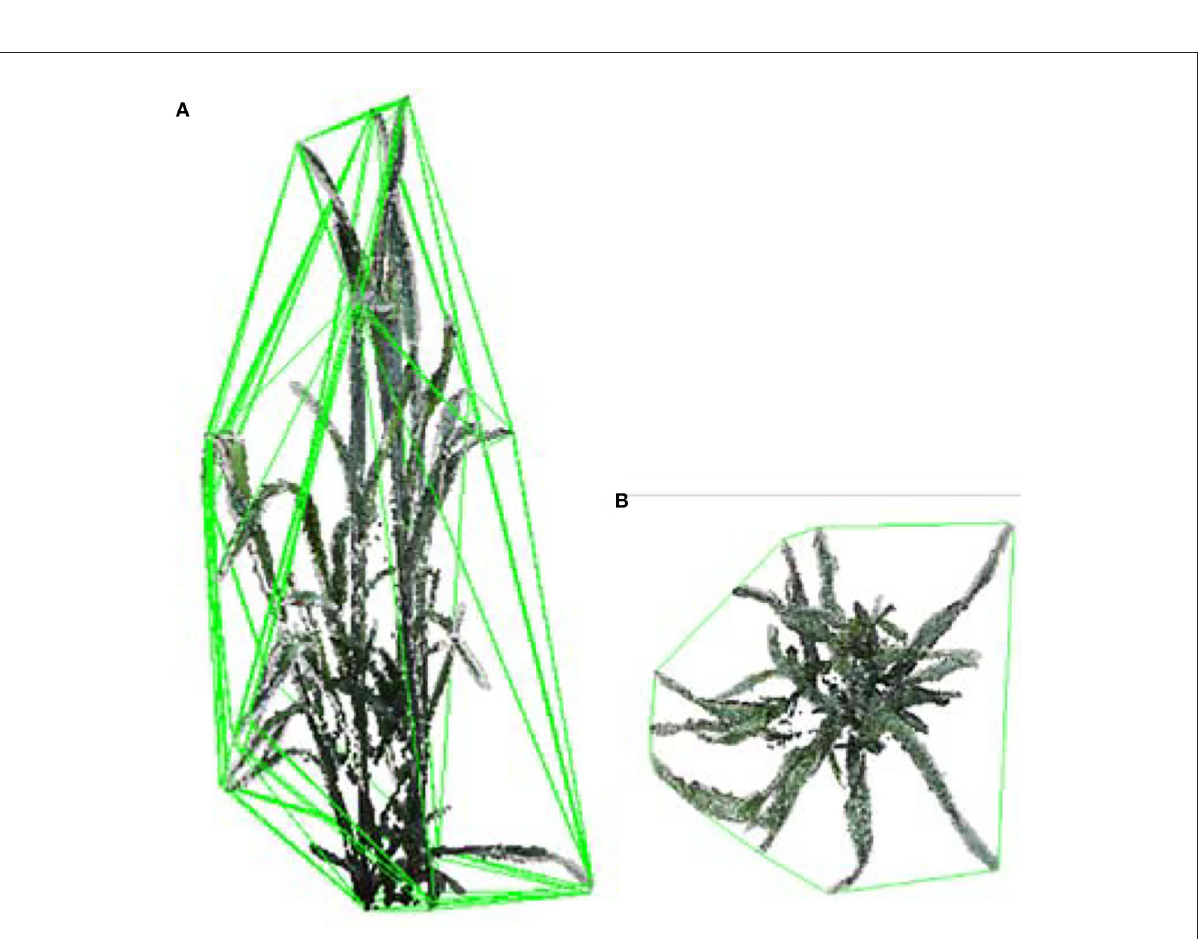
FIGURE7 The shoot convex volume and compactness calculation. (A) Convex hull volume of a wheat shoot. (B) Convex hull area of projected plant points on a